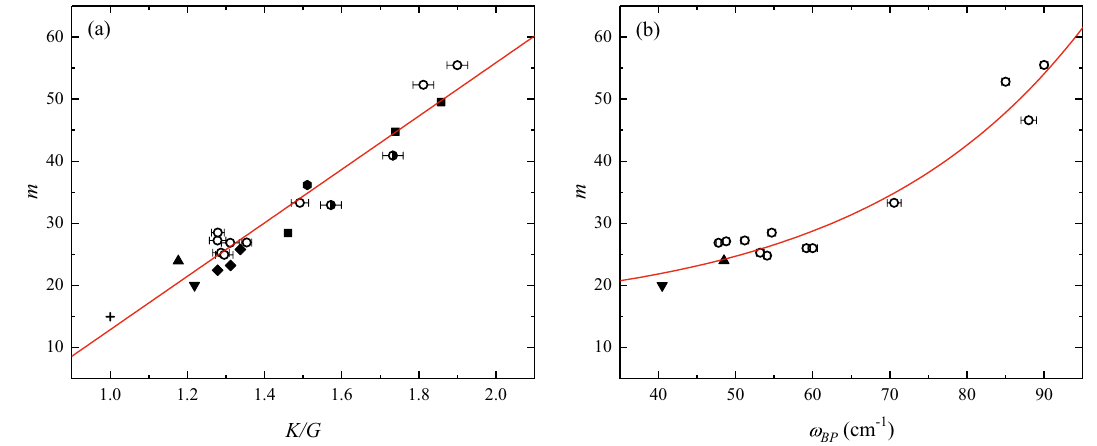
Figure 2. Melt fragility as a function of spectroscopic parameters of glass. ( a ) Relationship between the melt fragility m and ratio of the bulk and shear moduli K / G of anhydrous samples. The m parameter is derived by fitting anhydrous melt viscosity data from the literature with Eq. (1) assuming η ∞ = 10 −2.93 Pa s, whilst K / G is calculated using Eq. (3) and Brillouin velocities from this study and the literature. The two half-filled symbols indicate samples (Str and MSA) for which viscosity data used to derive m and Brillouin data from this study used to obtain K / G , are derived from different samples (see “Literature data” paragraph for details). The red line represents the linear fit of the data (Eq. 6). Samples used here are seven rhyolites (Rh series), MSA, Str, DGG-1, An, Di, SiO 2 , GeO 2 , And, Bas, Phon, Foid, HPG8_Na05, HPG8_K05, HPG8_Li05 and the synthetic sample (cross, see Literature data paragraph for references). Literature data in ( a ) are: (square) Whittington et al. 35 , (hexagon) Richet and Polian 40 , (diamond) Hushur et al. 41 , (solid upward triangle) Zanatta et al. 39 , (solid downward triangles), Novikov et al. 36 . ( b ) Relationship between the melt fragility m and ω BP position of anhydrous samples. The BP position is derived by fitting the low-frequency Raman spectra of the glasses using a log-normal equation (see “Materials, literature data and methods” paragraph for details). The red line represents the exponential fit of the data (Eq. 7). Samples used here are seven rhyolites (Rh series), DGG-1, An, Crd, Di, HO, SiO 2 and GeO 2 . The chemical composition and data sources are listed in Tables 1 and 2, respectively. Literature data in ( b ) are: (solid upward triangle) Zanatta et al. 39 , (solid downward triangle) Zanatta et al. 42